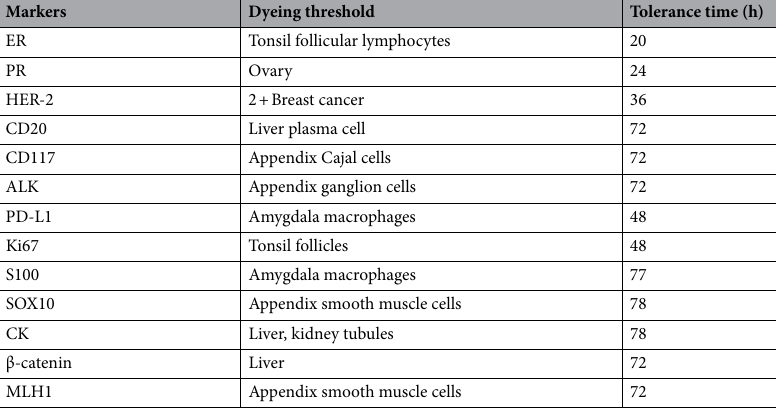
Table 4. Immunohistochemical marker tolerance to 8% TCCA bleaching duration.